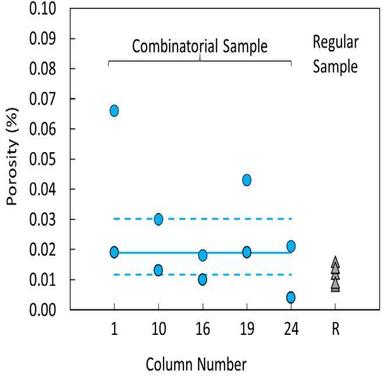
Porosity measurements versus column number (refer to) from combinatorial samples for the default laser power and scan speed compared against porosity measurements from a regular sample (R) for the default laser power and scan speed. The solid and dotted lines are the estimate and confidence interval determined for the default condition in the combinatorial sample.